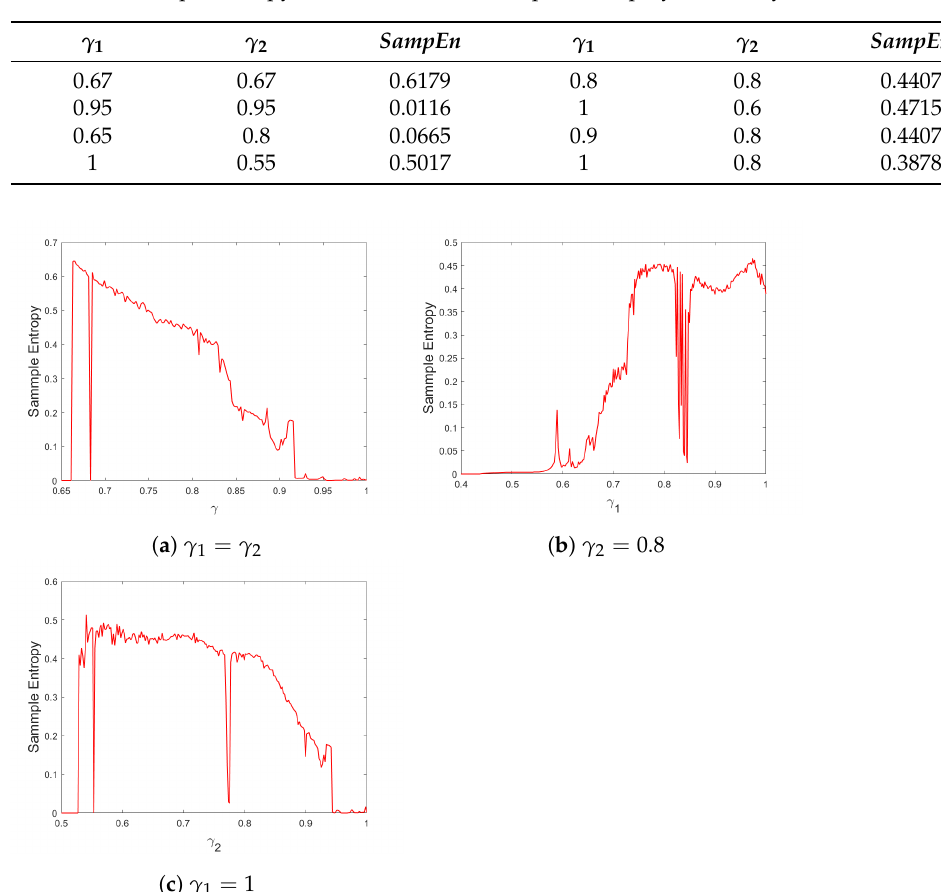
Figure 8. The sample entropy ( SampEn ) of the fractional predator-prey discrete system of Leslie type for a = 2.2, b = 5, c = 5.5, δ = 1.05 and initial conditions ( x ( 0 ) , y ( 0 )) = ( 0.9,0.56 )